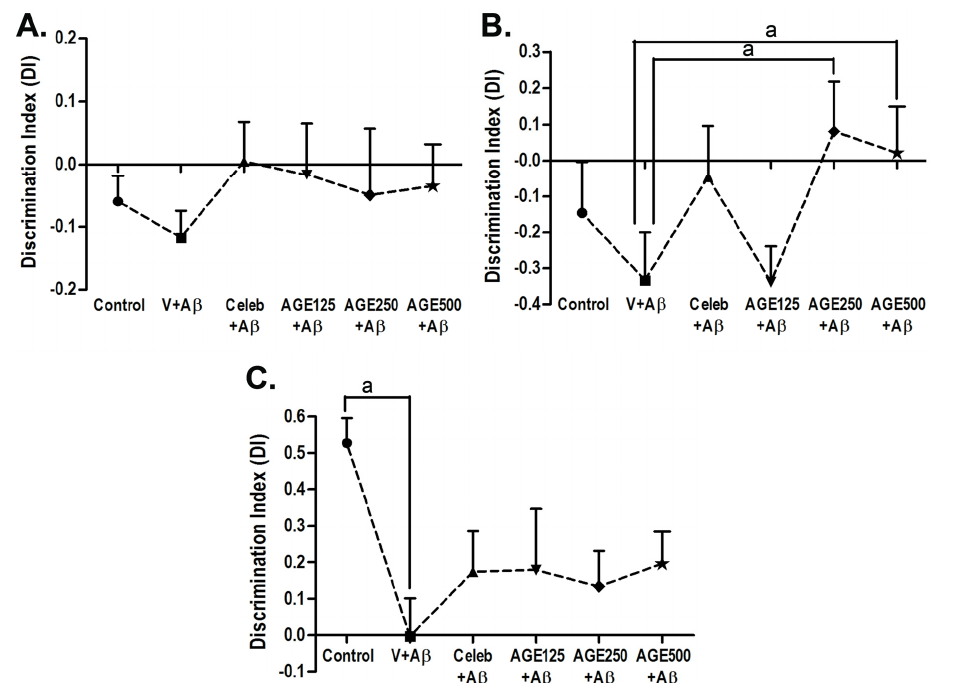
Figure 2. The discrimination index (DI) in the training phase ( A ); after a five-minute delay ( B ) and 24 h delay ( C ) in the novel object recognition test. Data are presented as mean ± S.E.M. (standard error of mean), a = significant differences from vehicle + A β group at p < 0.05.